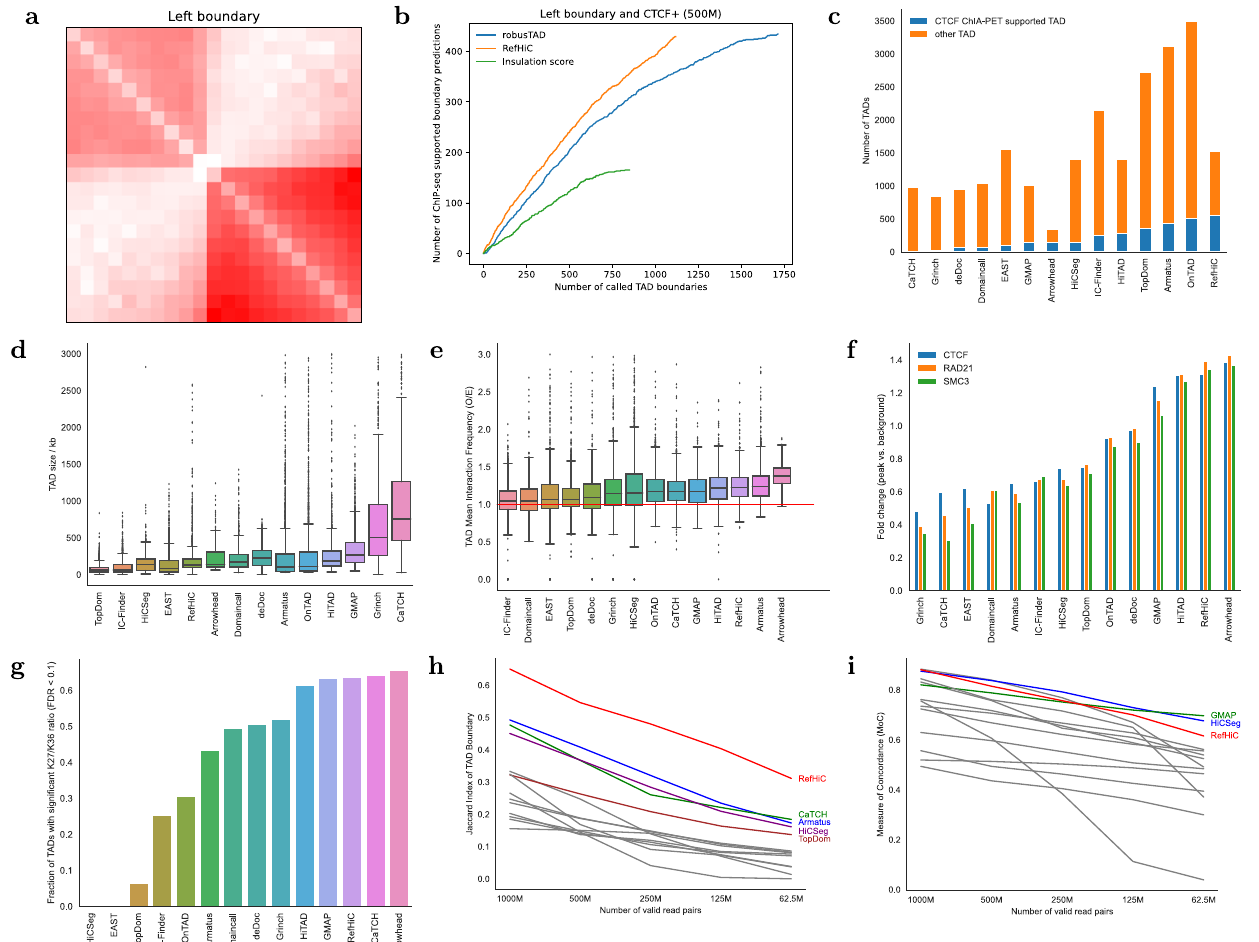
Fig. 6 | Detection of TAD boundaries and TADs on GM12878 Hi-C data. a TAD boundarypileupsforleftboundariespredictedbyRefHiC. b Numberofpredictedleft TADboundariessupported byChIP-seq identi fi ed CTCFbinding sites (positive strand only), for RefHiC, RobusTAD, and Insulation score. c – i Benchmarking RefHiC against 13 other TAD callers on TAD annotation. c Number of TADs predicted by different tools, and proportion of predicted TAD boundary pairs that are supported by CTCF ChIA-PET data. Size ( d ), and mean interaction frequency (observed/expected) ( e ) of TADpredictions.ThenumberofTADsusedtogeneratedboxplotsareprovidedin( c ). Ineachbox,theupperedge,centralline,andloweredgerepresentthe75th,50th,and